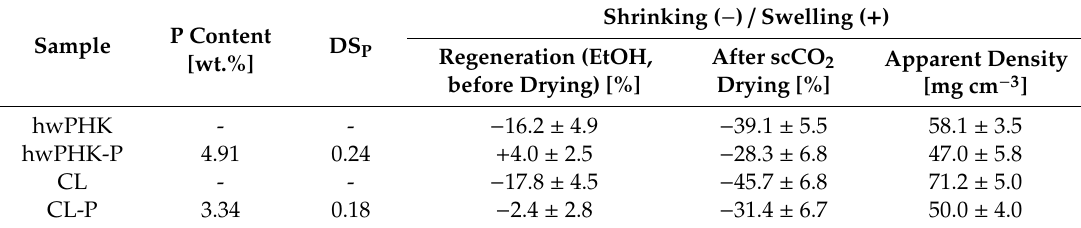
Table 1. Phosphorous contents, DS P values (degree of phosphorylation), and selected properties of 3% cellulose phosphate lyogels and aerogels compared to the non-derivatized starting materials. The range of variation represents the 95% confidence